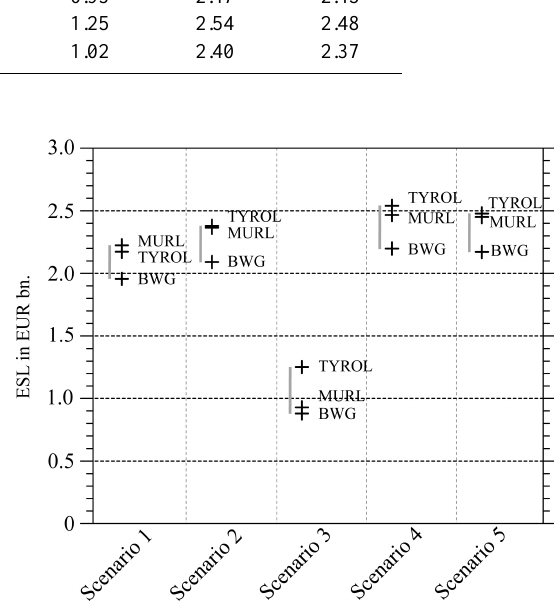
Fig. 11. Range of the analysed ESL for buildings and inventory according to the different applied approaches BWG, MURL, and TYROL in